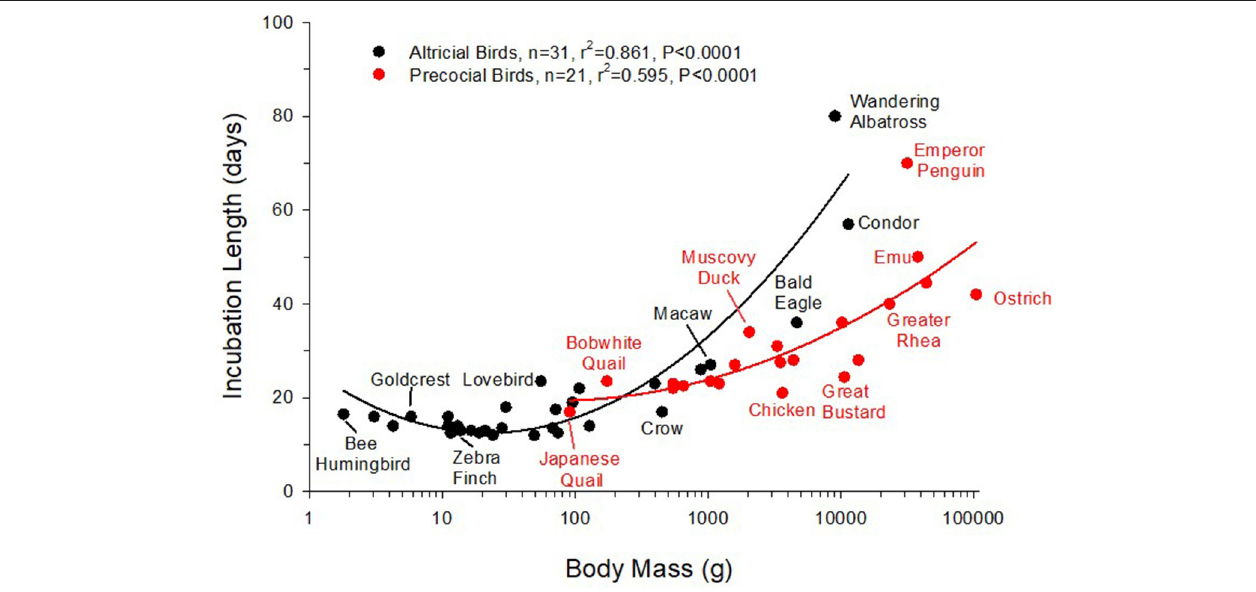
FIGURE 4 | Relationship between body mass and egg incubation length in altricial and precocial birds. Body masses are the average for the species. Second order linear regressions are shown separately for precocial birds (black lines) and altricial birds (red